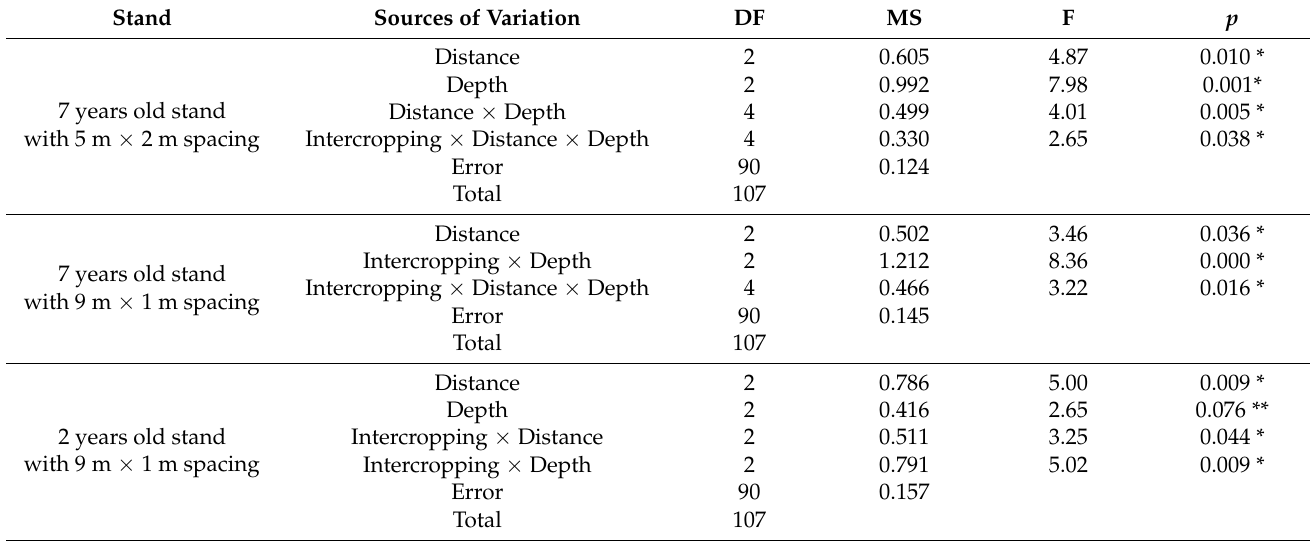
Table 1. ANOVA results for variations in root dry mass of E. camaldulensis at different soil depths as affected by intercropping and distance from the tree for stands with 5 m × 2 m and 9 m × 1 m spacing.